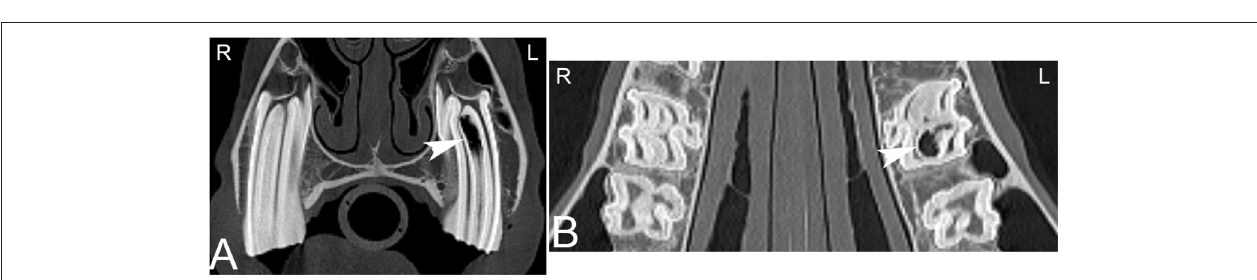
FIGURE 7 | Apical infundibular cemental hypoplasia. Transverse (A) and dorsal (B) computed tomography images displayed in a bone window in a 14-year-old pony mare. Gas is present in the apical aspect of the infundibulum of Triadan 209 (white arrow heads). L, left; R, right.